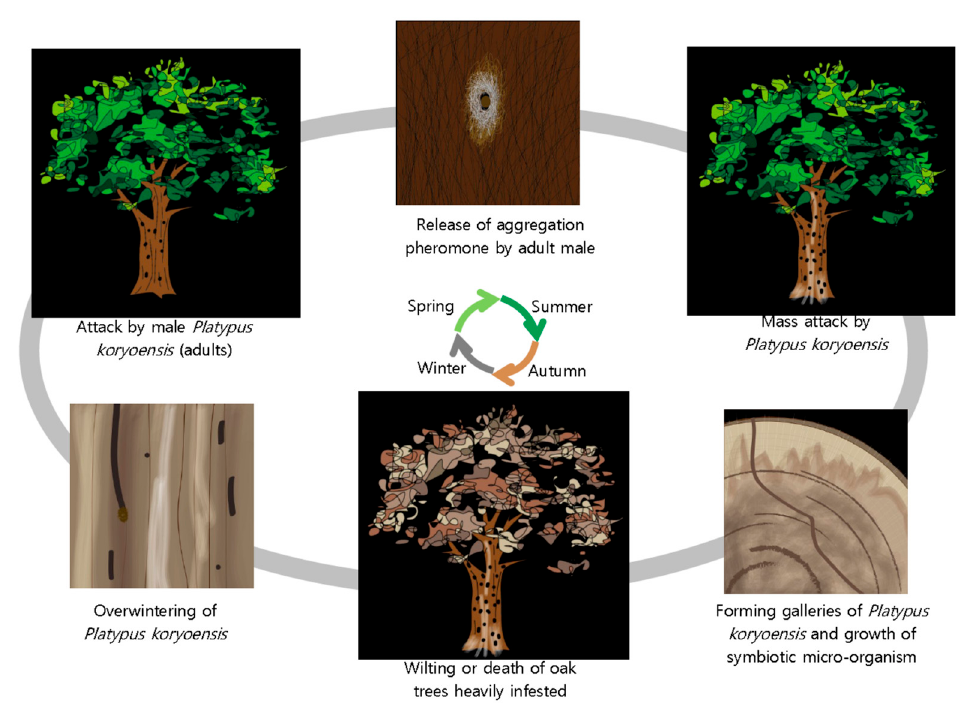
Figure 4. Life cycle of KOW in Korea. The graph was redrawn based on data from research on disease cycle and management of KOW [20] .